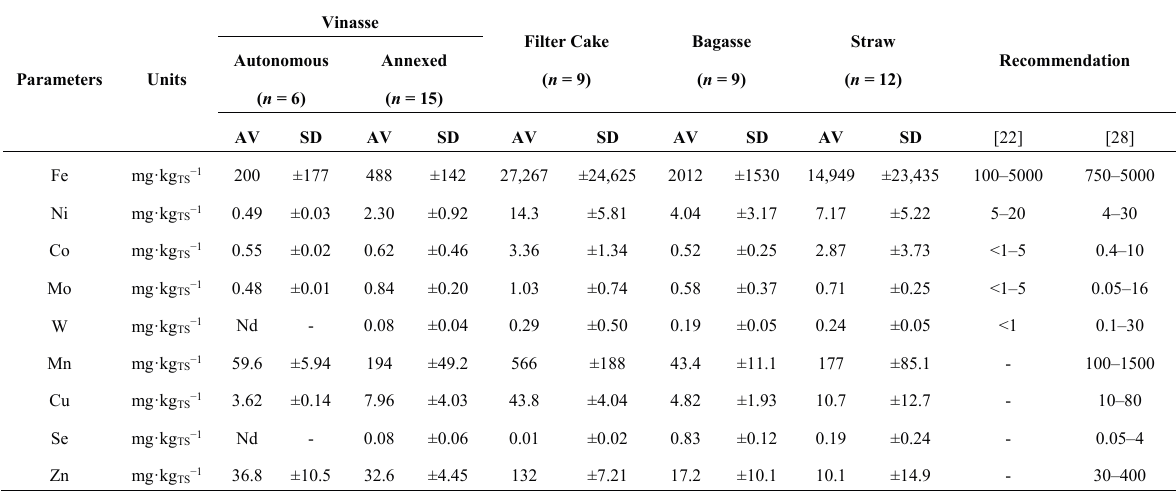
Table 2. Trace elements content of the sugarcane